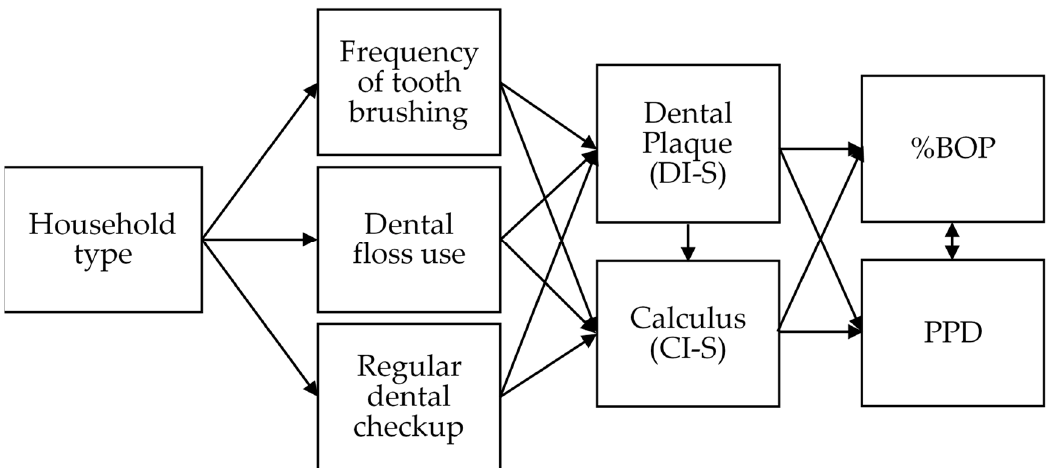
Figure 1. Pathway based on hypothesis showing the association between household type, oral health behavior, oral hygiene status; Debris Index-Simplified (DI-S) and Calculus Index-Simplified (CI-S), percentage of bleeding on probing (%BOP), and probing pocket depth (PPD).